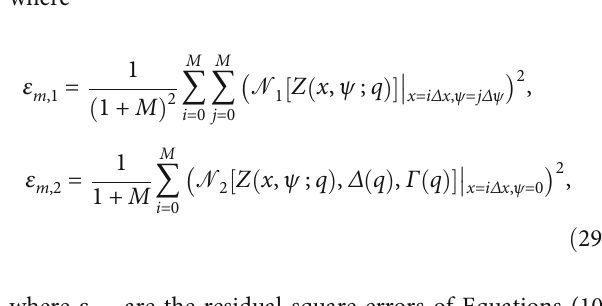
Þ for di ff erent wave amplitude μ 0